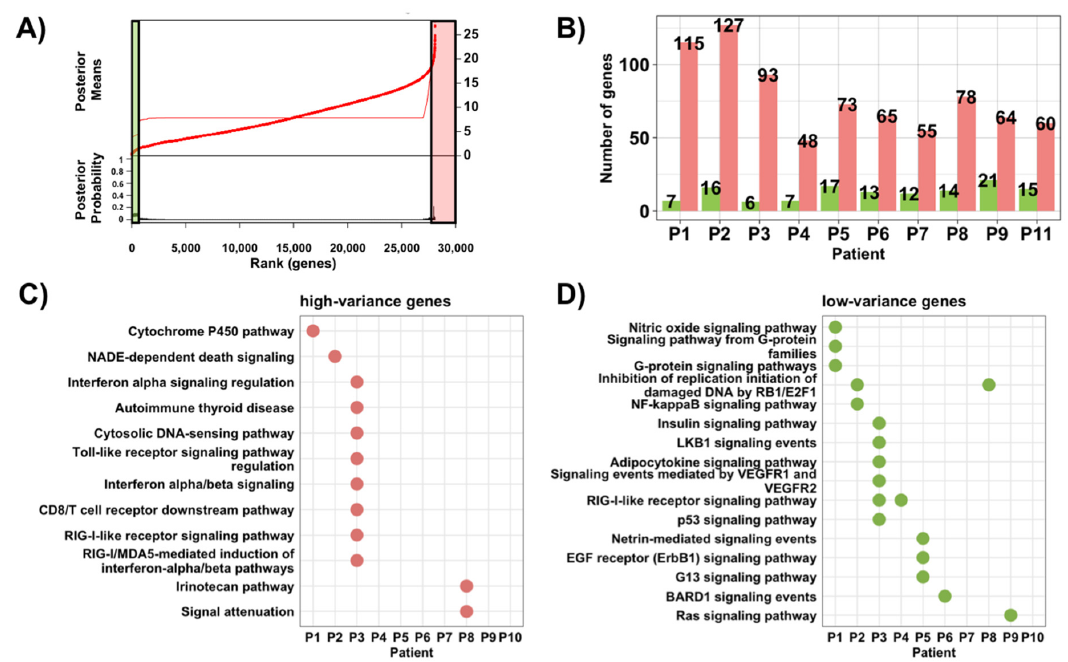
Figure 6. Identification of gene signatures with high and low regional gene expression heterogenetiy within patients. ( A ) Example of a Bayesian changepoint model to assess the distribution of gene distance measures to define genes with high (pink) and low expression variability (green). ( B ) Frequency distribution of the number of genes with high (pink) and low (green) ITH in their expression levels based on a Bayesian changepoint model. ( C , D ) Dot plot showing BioPlanet pathways significantly ( p < 0.05) enriched for gene sets with high and low ITH. The dots are color-coded according to the p -value.